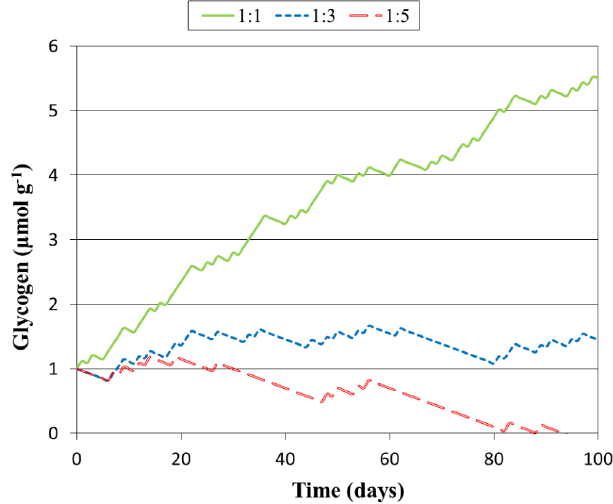
Figure 3. Predicted glycogen depletion over 1 month under three climate scenarios, where the ratio of light:dark wetting events is 1 : 1, 1 : 3, and 1 :